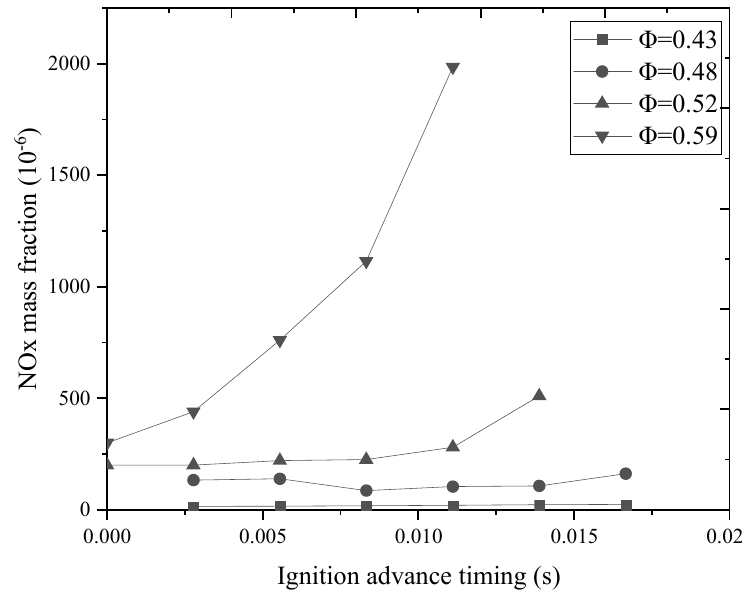
Figure 17. NOx production changes with ignition advance timing.